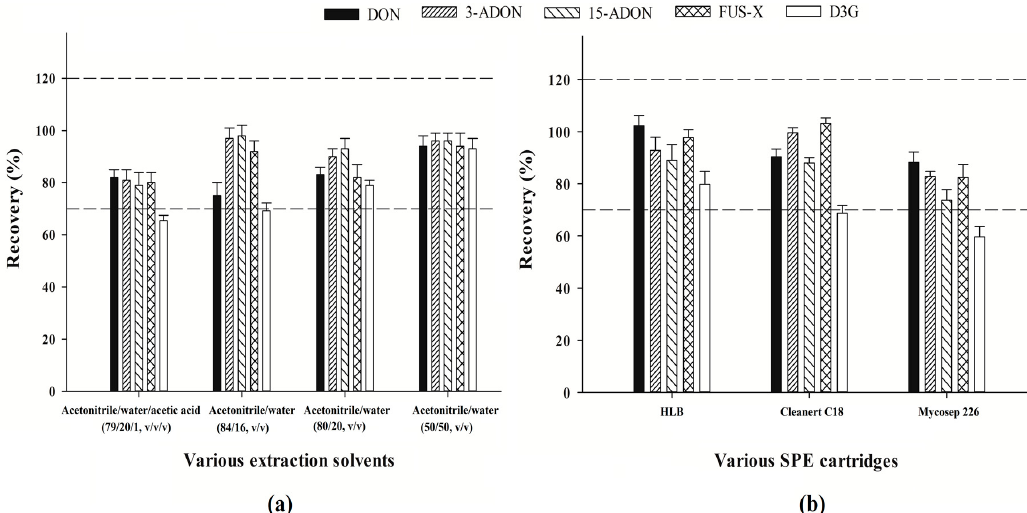
Figure 1. Comparison of the extraction efficiencies of the five mycotoxins by the four candidate extraction solvents ( a ) and purification efficiencies by three different clean-up cartridges ( b ) using blank formula feed samples spiked with 50 μ g/kg of each mycotoxin. The error bar represents standard deviation ( n = 3) and acceptable recoveries are in the range of two dashed lines (70%–120%).